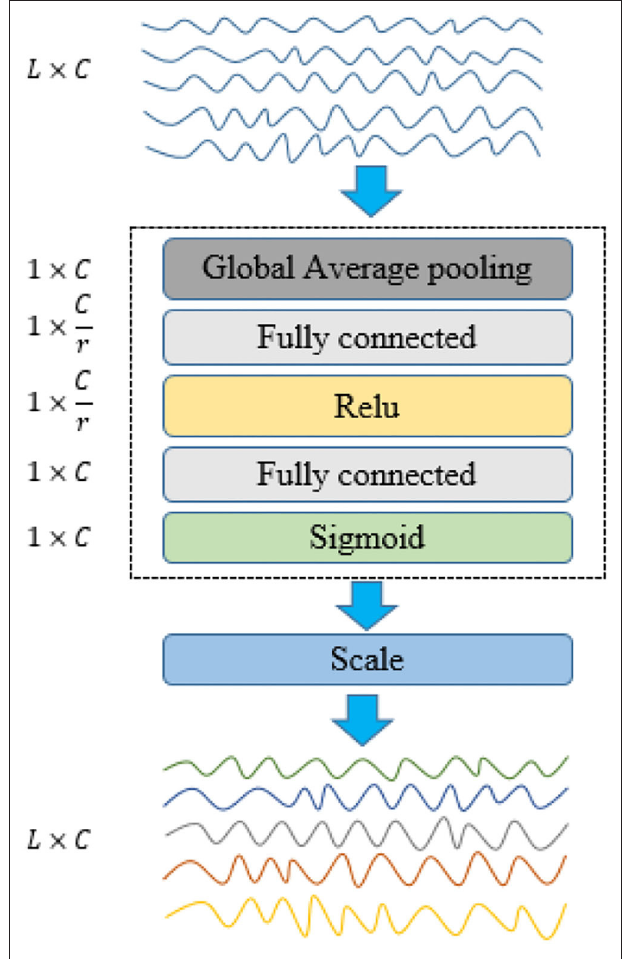
FIGURE 3 | Structure diagram of SENet network applied to one dimensional EEG signal. The weight of each channel of EEG signal before processing is equal, so the color of the channel is the same. The different channels after processing were assigned different weights, with different colors representing this